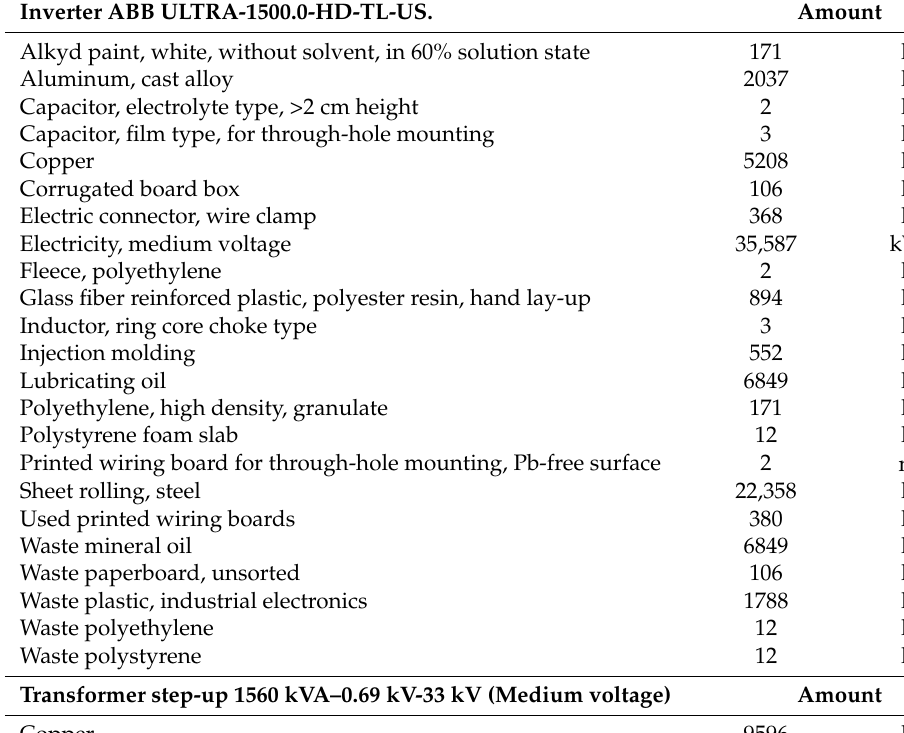
Table A2. Life Cycle Assessment Inventory for the inverter. Inverter ABB ULTRA-1500.0-HD-TL-US. Amount Alkyd paint, white, without solvent, in 60% solution state 171 kg Aluminum, cast